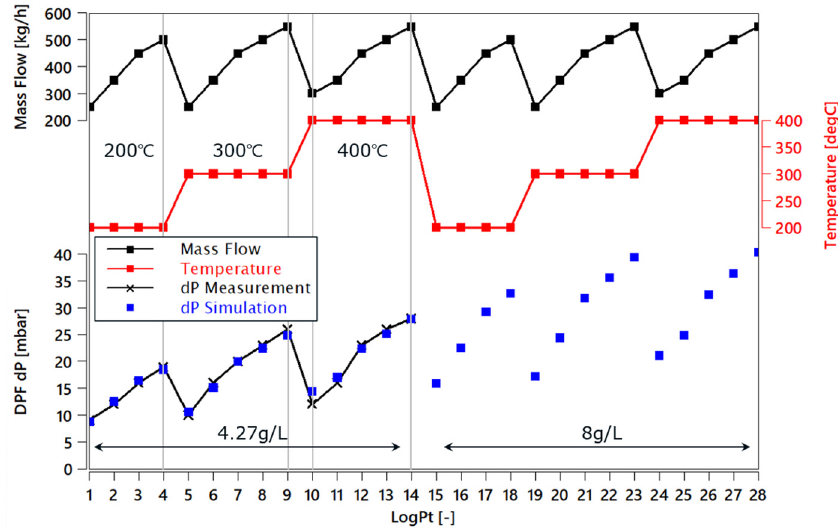
Figure 8. Differential pressure of 4.27 g/L Soot Loading DPF and Boundary Conditions.